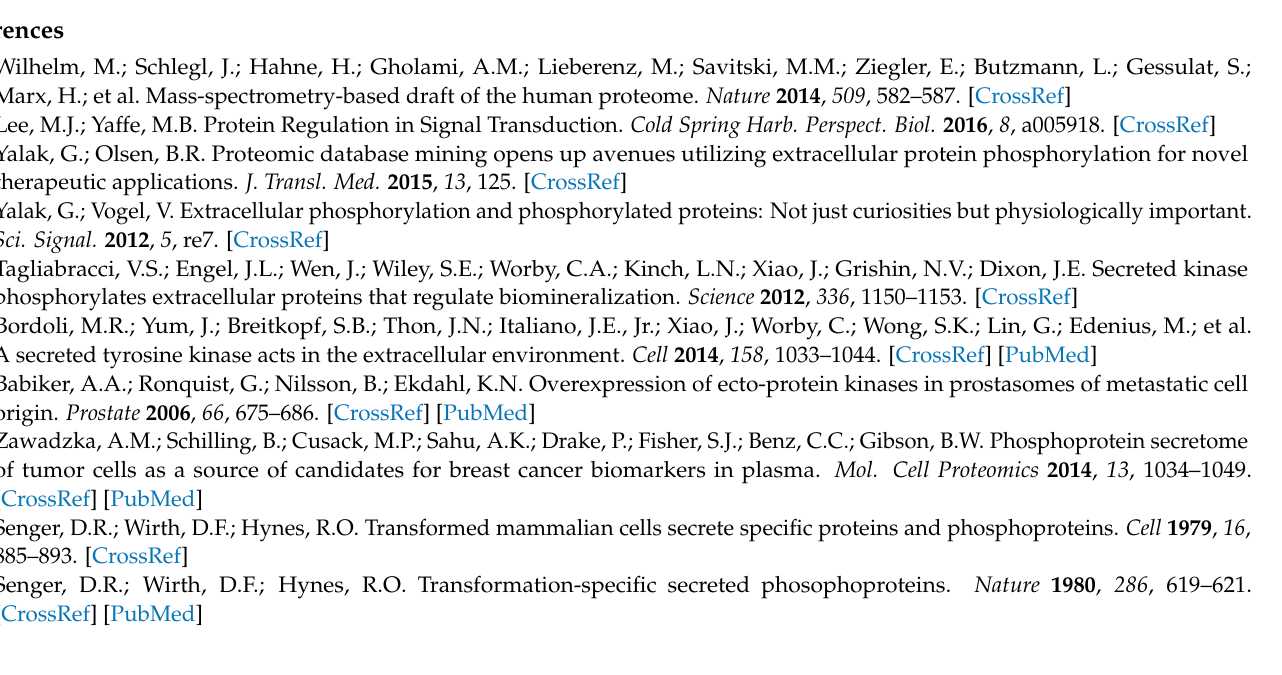
cropped section, Figure S2: Unprocessed blot image in Figure 3a. Red square indicates cropped section, Figure S3: Unprocessed blot image in Figure 6a. Red square indicates cropped